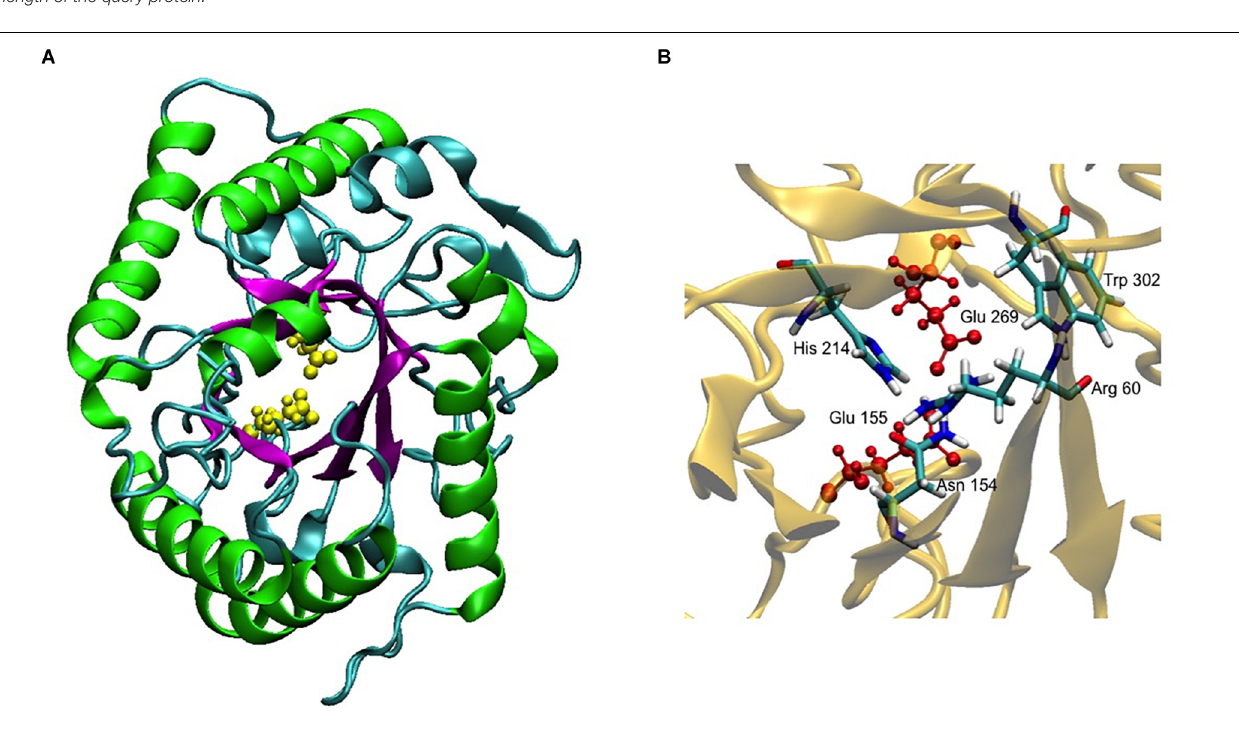
FIGURE 3 | 3D model of CelRH5. (A) TIM-barrel fold ( β / α ) 8 present in GH5 (magenta and green) and the two catalytic Glu in yellow. (B) Conservative residues involved in